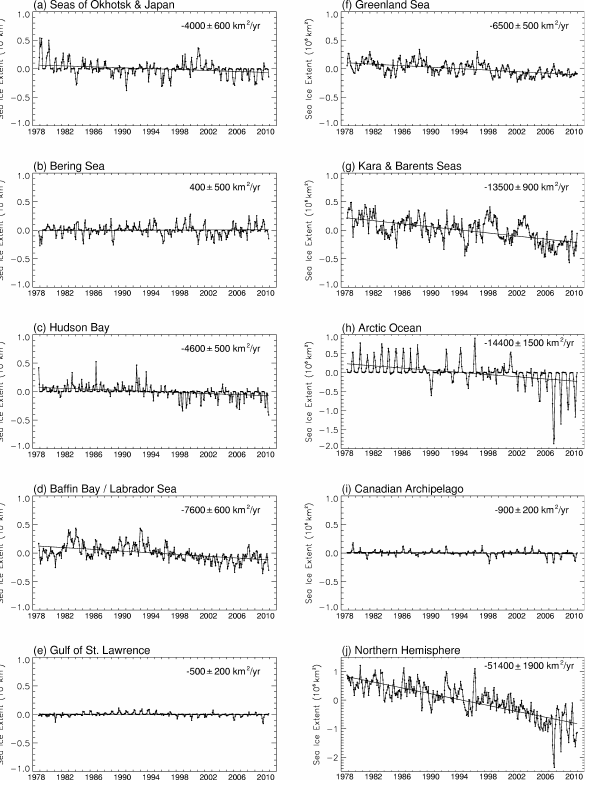
Fig. 3. Monthly deviations of the sea ice extents for (a) Seas of Okhotsk and Japan, (b) Bering Sea, (c) Hudson Bay, (d) Baffin Bay/Labrador Sea, (e) Gulf of St. Lawrence, (f) Greenland Sea, (g) Kara and Barents Seas, (h) Arctic Ocean, (i) Canadian Archipelago, and (j) Northern